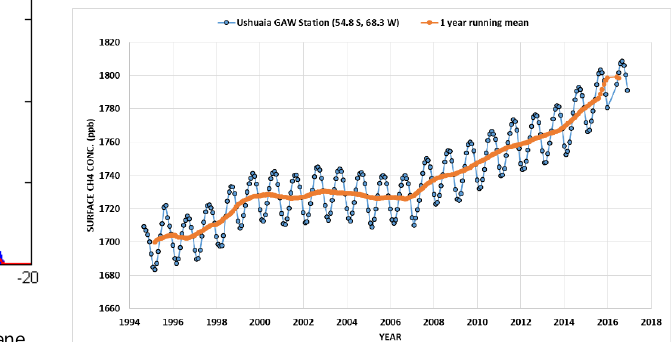
Figure 4. Zonal mean (15S-53S) methane column average dry air mixing ration (ppb) from SIAMACHY (2003-2009) and GOSAT (2009-2018).